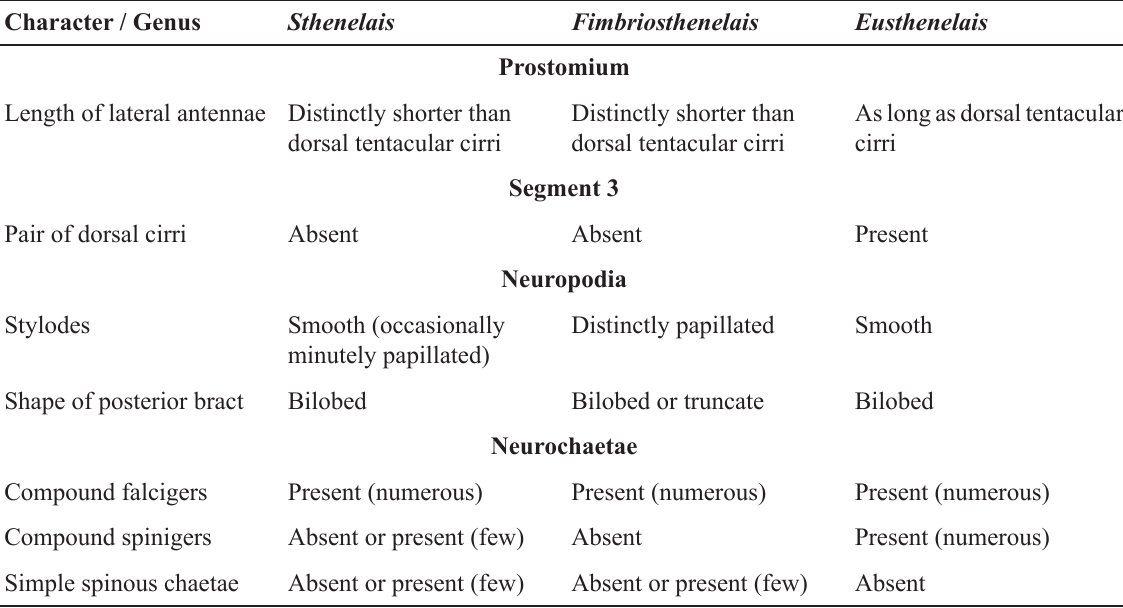
Table 1. Diagnostic generic characters of Sthenelais Kinberg, 1856, Fimbriosthenelais Pettibone, 1971 and Eusthenelais McIntosh,